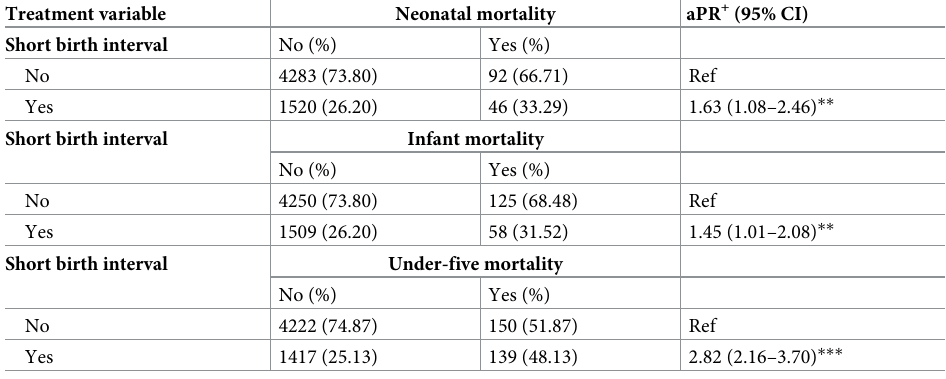
Table 4. The effect of short birth interval on neonatal, infant and under-five mortality in Bangladesh, BDHS